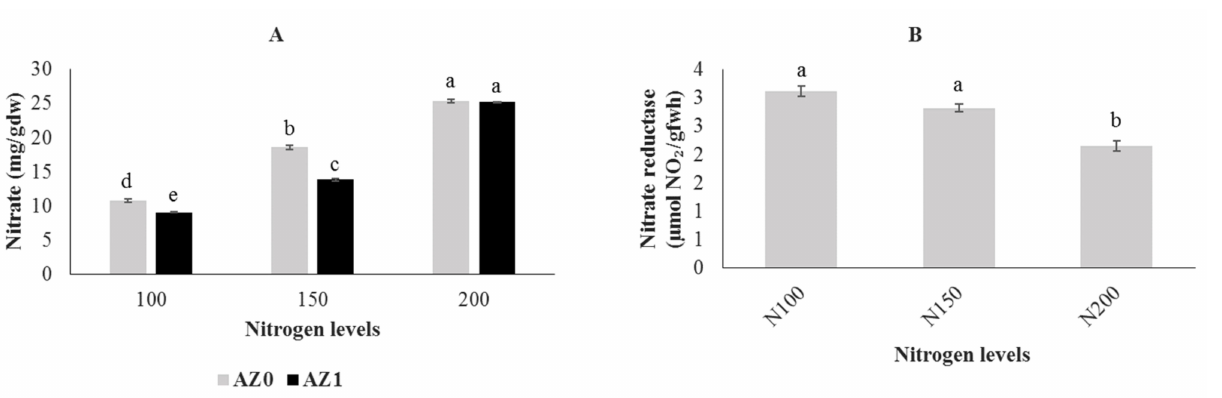
Figure 6. Nitrate accumulation ( A ) and nitrate reductase activity ( B ) in hydroponically grown lettuce influenced by Azotobacter under different nitrogen levels. The letters indicate the mean comparison using LSD test ( p < 0.05) which was implemented for examining the differences among the